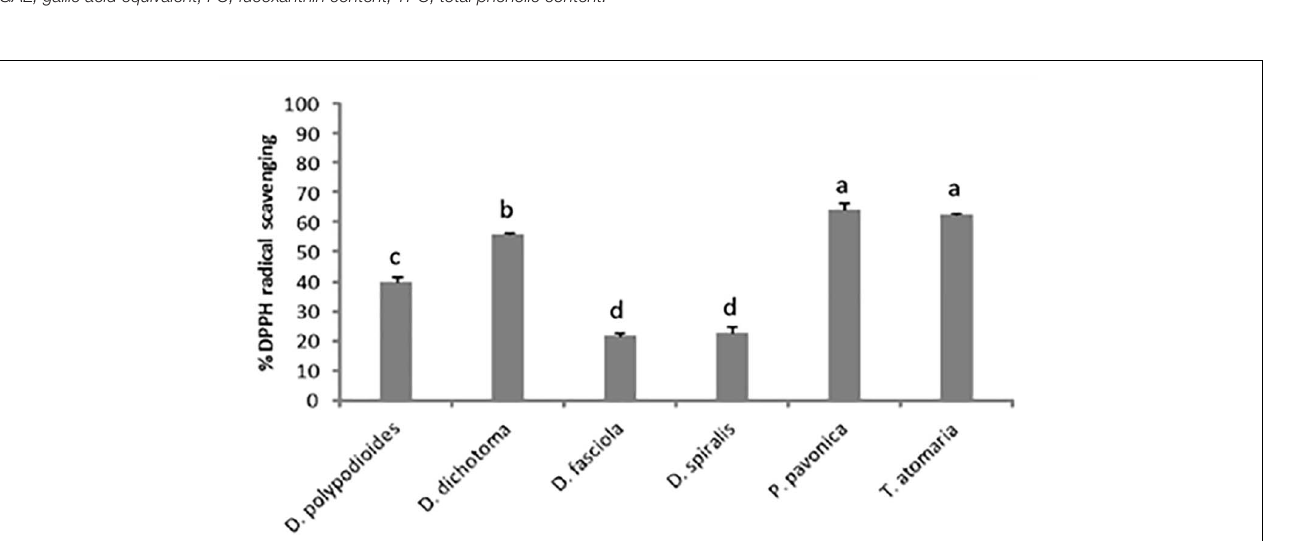
and D. spiralis gave significantly the lowest DPPH inhibition